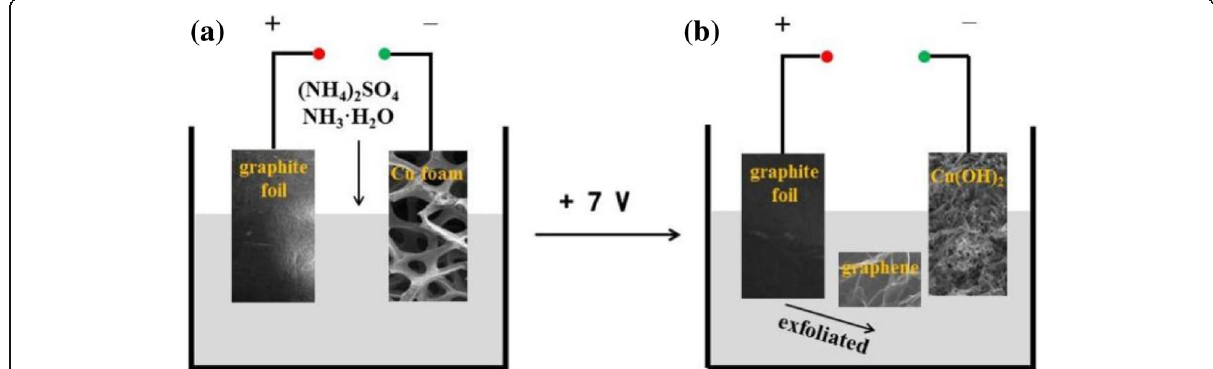
Fig. 1 Schematic diagram of the experimental set-up of one-step in situ self-assembly of Cu(OH) 2 /graphene composite